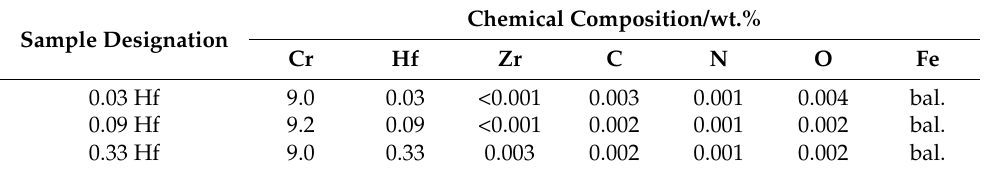
Table 1. Chemical compositions of the alloys used in the present